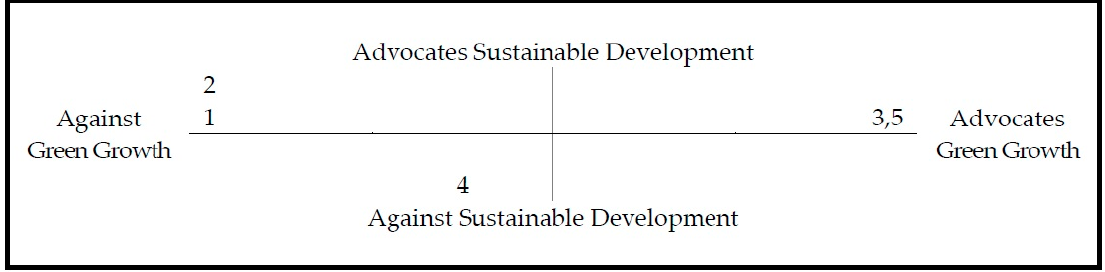
Figure 3. Policy Figure 3. Policy Core. Figure 3. Policy Core.